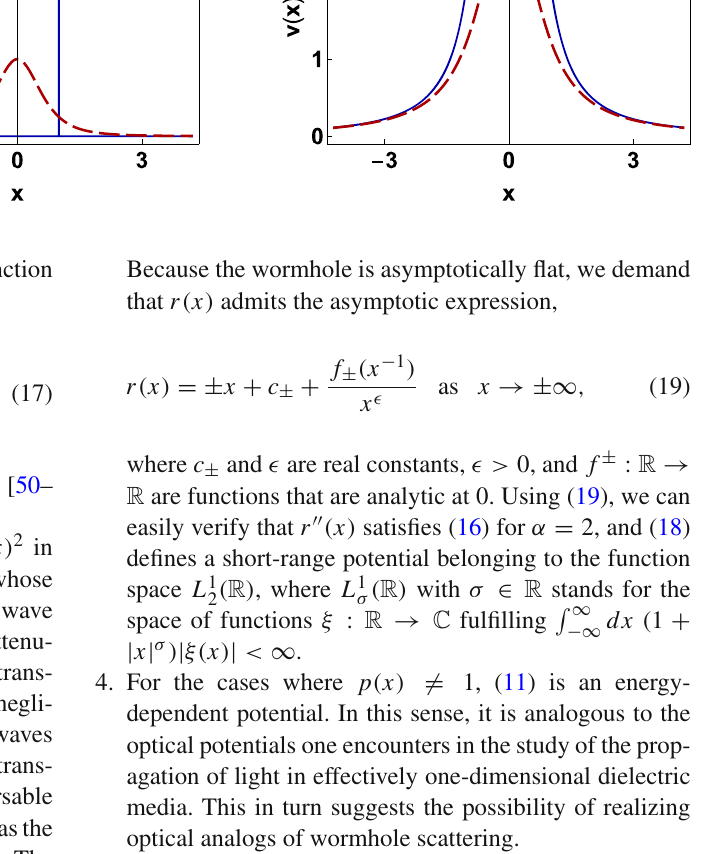
Fig. 2 Plots of the potentials (13) for the Ellis wormhole (dashed red curve) and (15) for a wormhole with sharp transition (solid blue curve) with r 0 = x 0 = 1 and l = 0 (on the left) and l = 1 (on the